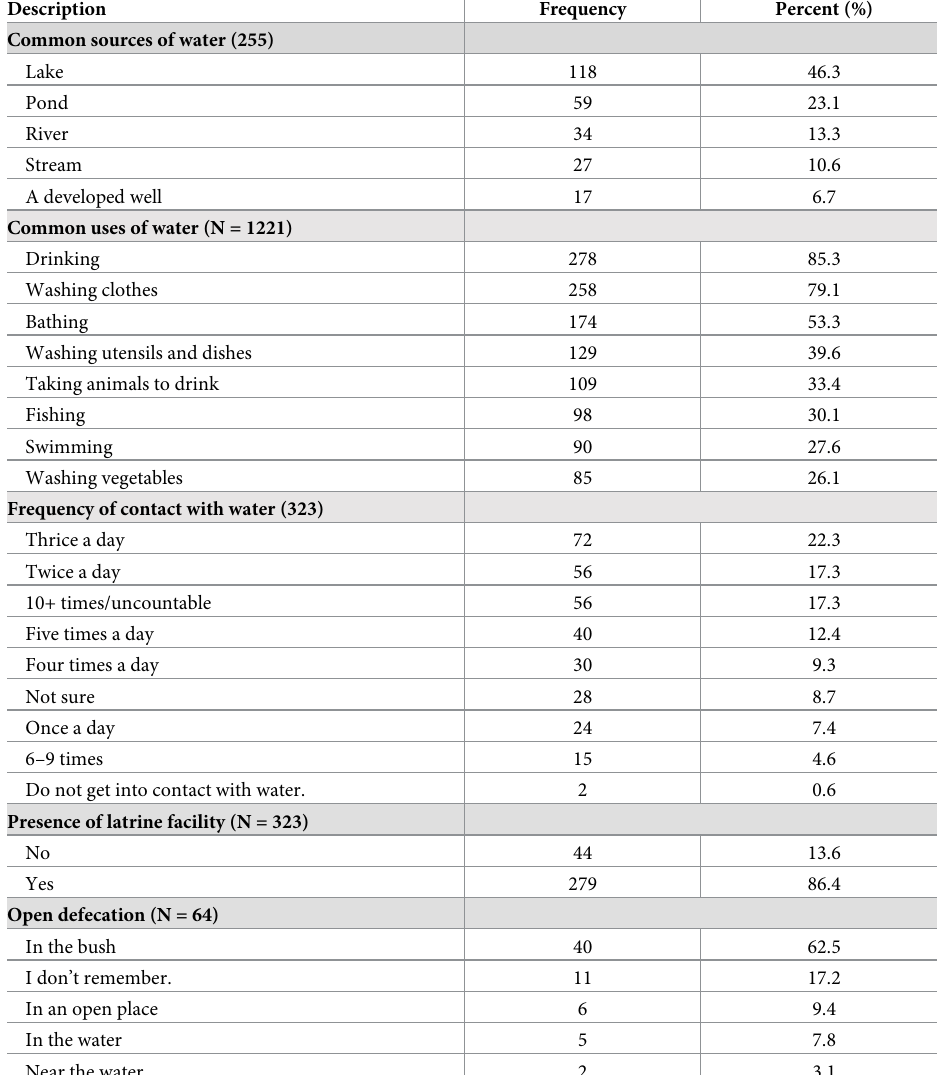
Table 6. Respondents’ practices regarding